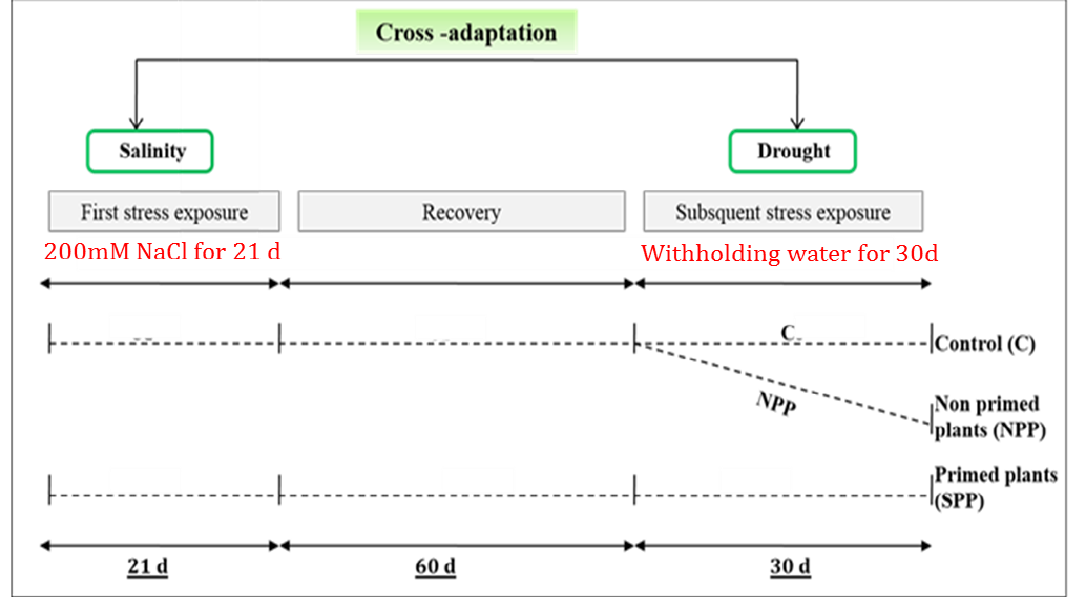
Figure 1. Diagram of the experiment design. C: control plants, well-watered during 111 d experiment; NPPs: nonprimed plants, well-watered for 81 d and then stressed by withholding water for 30 d; SPPs: salt-primed plants, primed by exposure to salinity (200 mM NaCl) for 21 d, recovered for 60 d, and then exposed to water depletion for 30 d as with the NPPs.